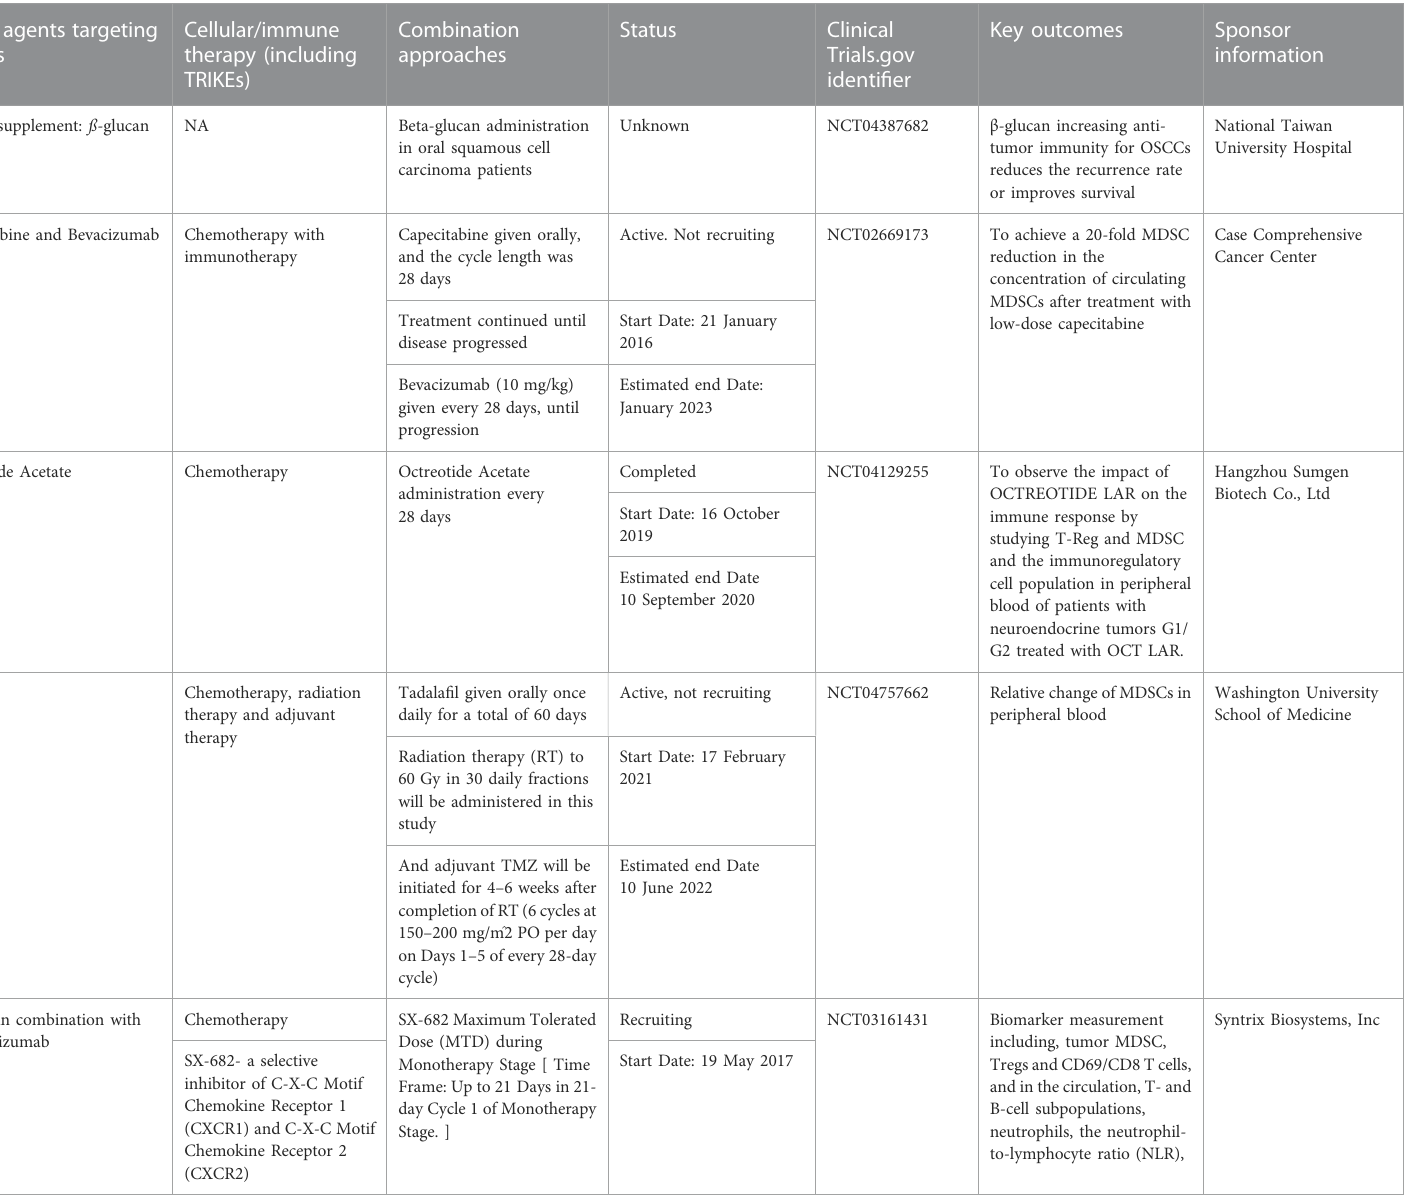
TABLE 2 Clinical trials performed worldwide for MDSCs (listed in